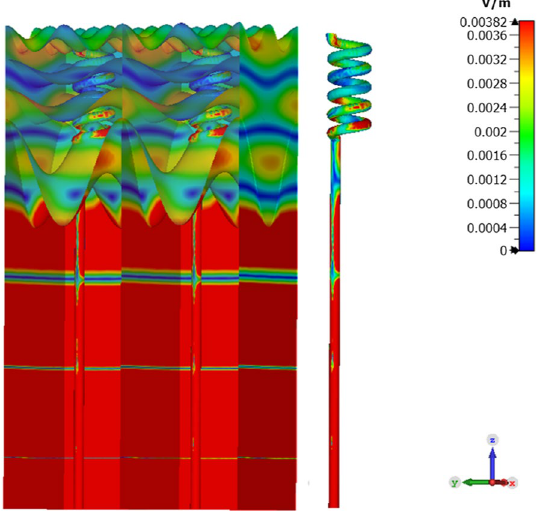
Figure 10. Electric field distribution in a fine resolution at 550 GHz. The sweat duct demonstrates performance of a conduit for the EM signal emitted from the core of the skin toward the skin surface This figure was generated using CST STUDIO SUITE v2021 30 , https:// www. 3ds. com/ produ cts- servi ces/ simul ia/ produ cts/ cst- studio- suite/.